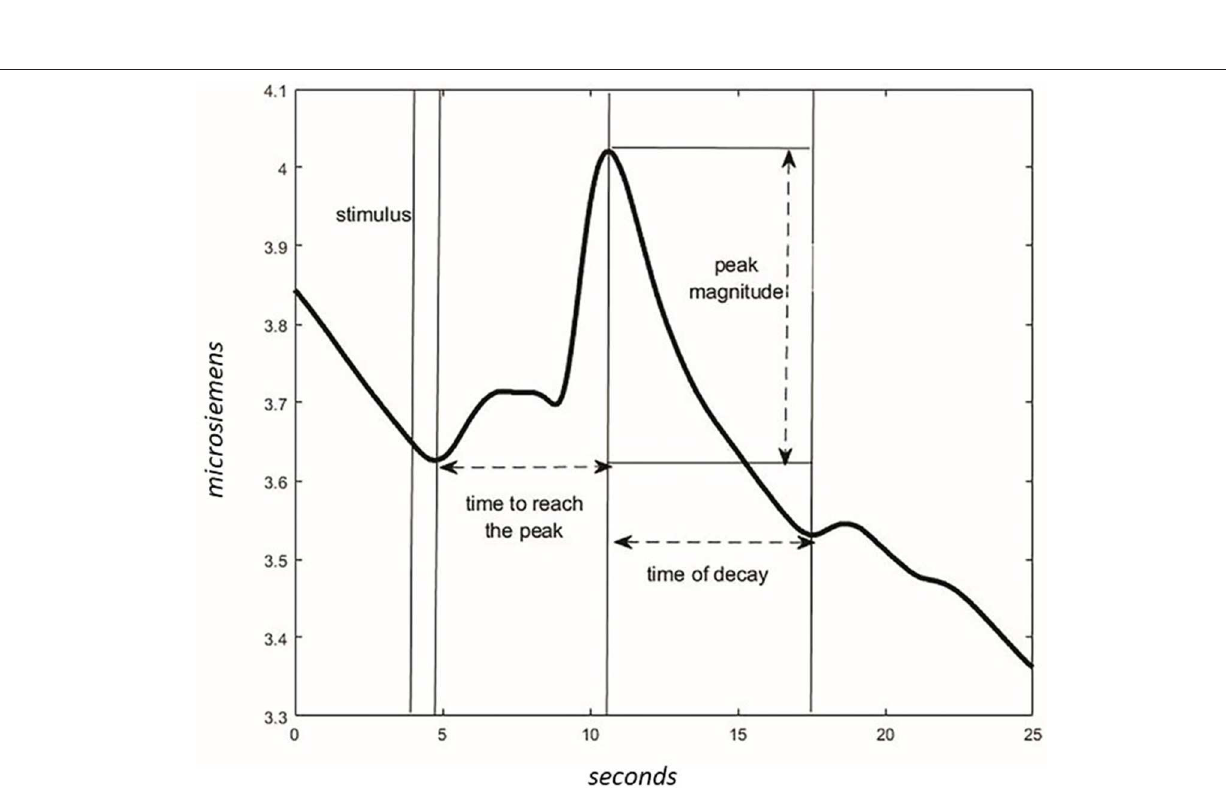
Frontiers in Human Neuroscience | www.frontiersin.org